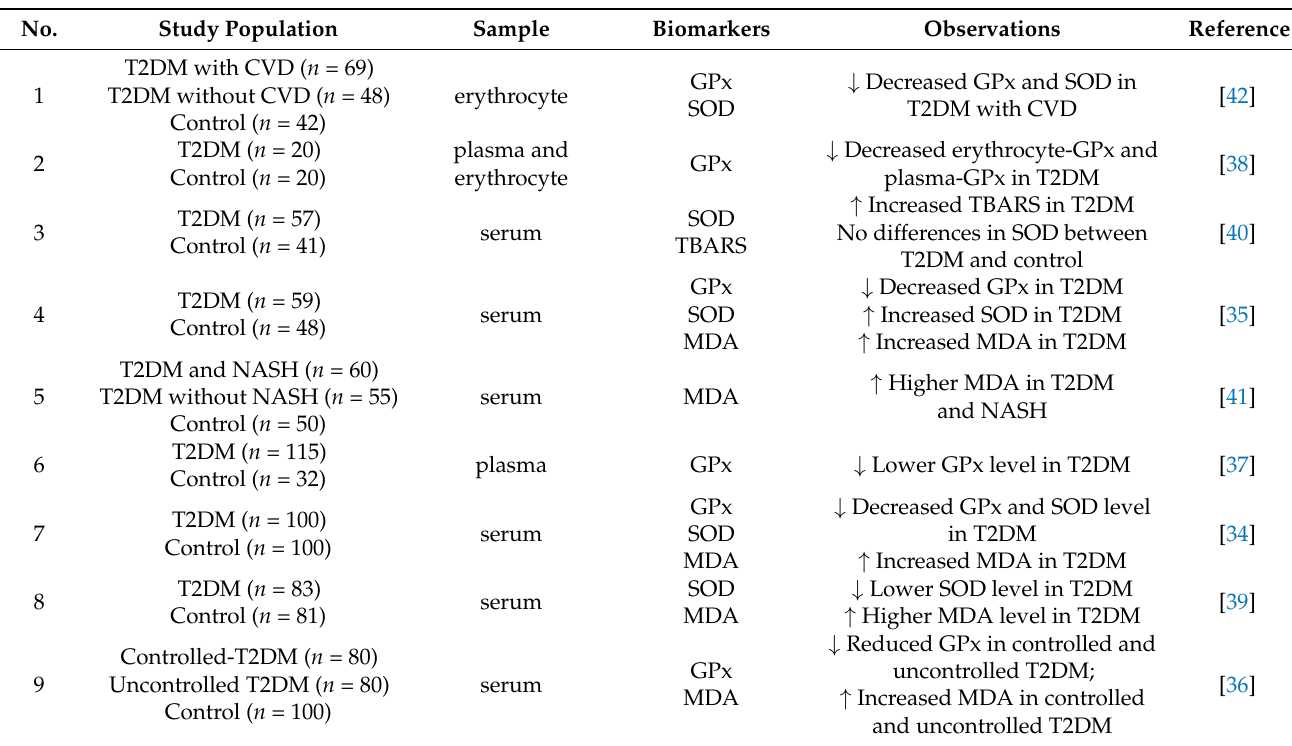
Table 1. Clinical studies on peripheral antioxidant capacity in pre-T2DM, T2DM with and without